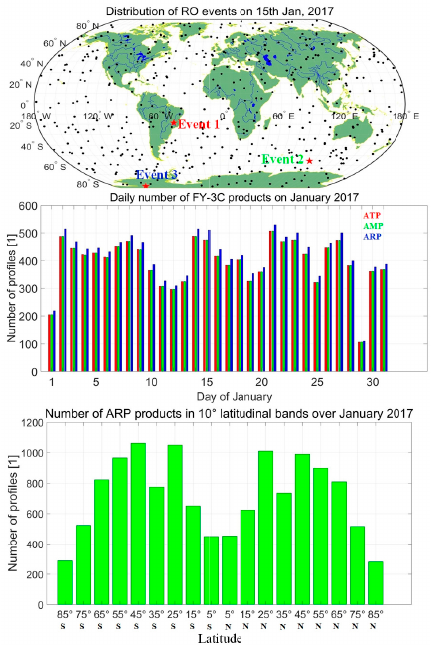
Figure 2. Global distribution of RO events on 15 January 2017 (top panel), number of daily products for January 2017 (middle panel) and numbers of FY-3C ARP products for January 2017 in 10 ◦ latitudinal intervals (bottom panel); the marked three stars are the three RO events for single RO performance illustrated in Figure